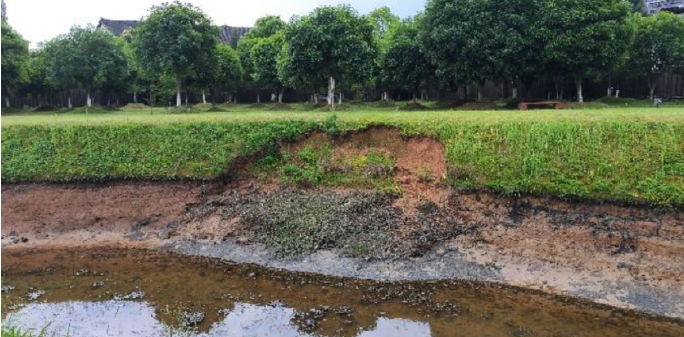
Figure 1. Destruction of the earthen ruins of Liye.